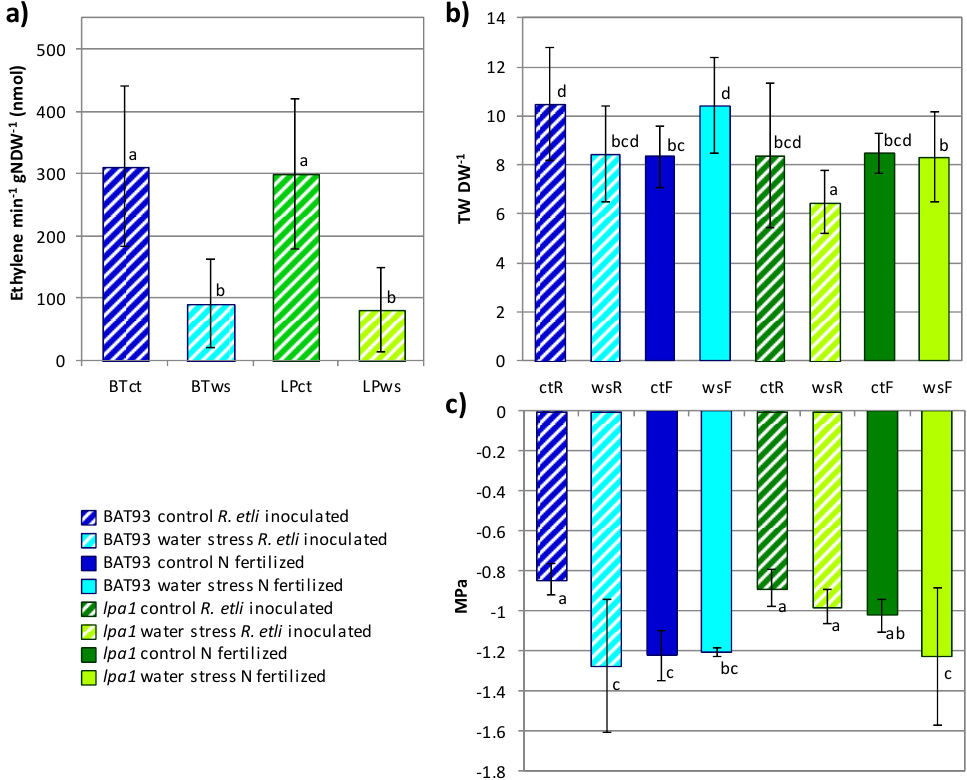
Figure 1. Nitrogenase activity measured by the acetylene reduction assay (ARA) ( a ), turgor weight (TW) to dry weight (DW) ratio ( b ) and osmotic potential ( c ) from inoculated or fertilized BAT 93 (BT, blue) and ( low phytic acid ) lpa1 (LP, green) plants. Dashed and solid bars correspond to Rhizobium etli inoculated (R) and to fertilized (F) plants, respectively. Plants from the control treatment (ct, dark color) and from the water stress treatment (ws, light color) at 14% soil moisture were analyzed. Equal lowercase letters correspond to equal mean for analysis of variance (ANOVA) with Tukey honest significant difference (HSD) ( a , c ) or Tamhane T2 post hoc test ( b ). Bars represent ± Standard Deviation (SD). Nodule dry weight: gNDW.